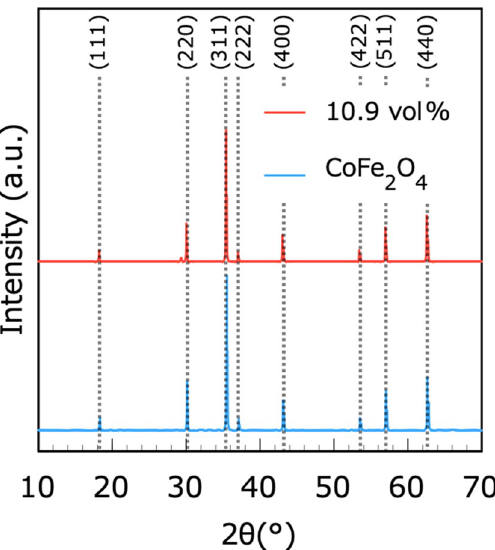
Figure 3. XRDs patterns of the 10.9 vol% CNF–CoFe 2 O 4 composite paper (red) and CoFe 2 O 4 particles (blue).